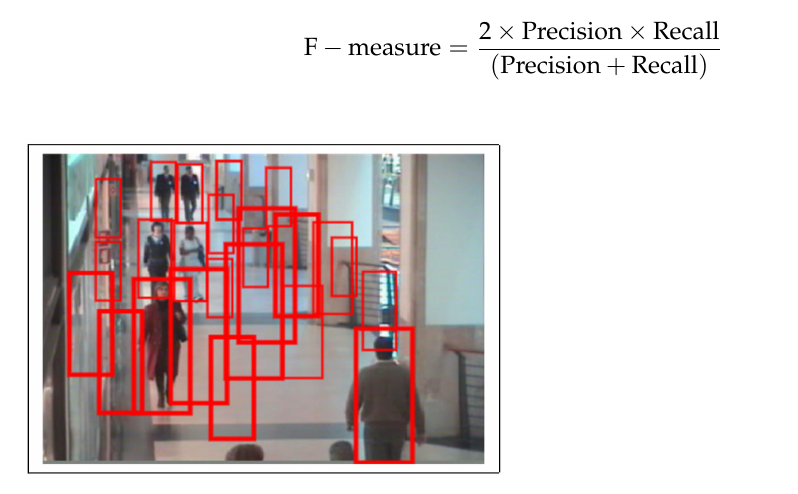
Figure 21. Low precision and high